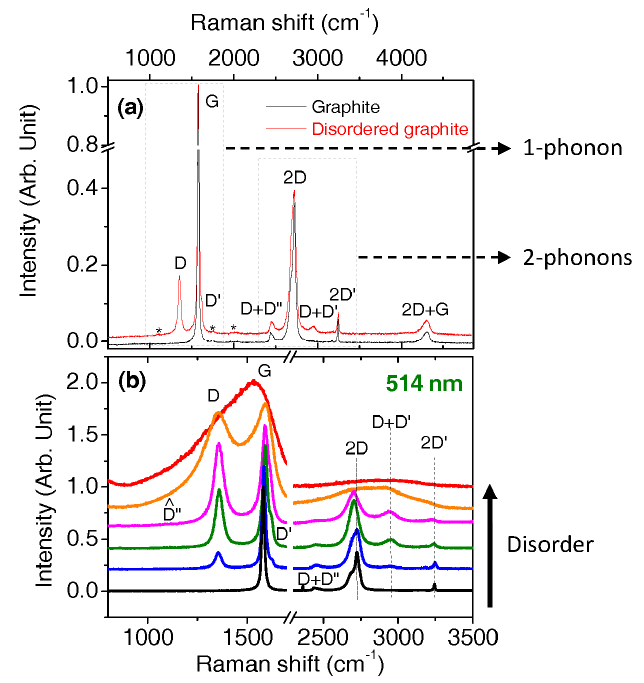
Figure 6. Raman spectra of graphite and disordered carbons recorded at 514 nm. ( a ) Attribution of the main bands in the first, second, and third order regions. ( b ) Same for a variety of more disordered carbons.